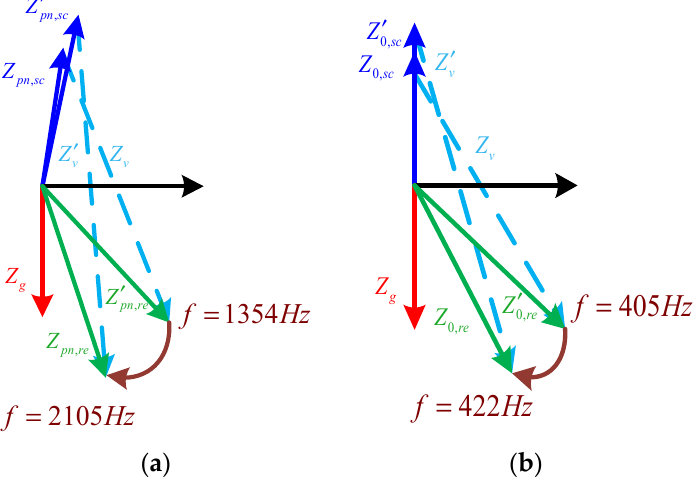
Figure 7. Analysis diagram of the impedance vector condition of the ideal reshaping process of LCL-TFSCI with SCR changing. ( a ) Ideal reshaping process for positive and negative sequence system; ( b ) Ideal reshaping process for zero-sequence system.